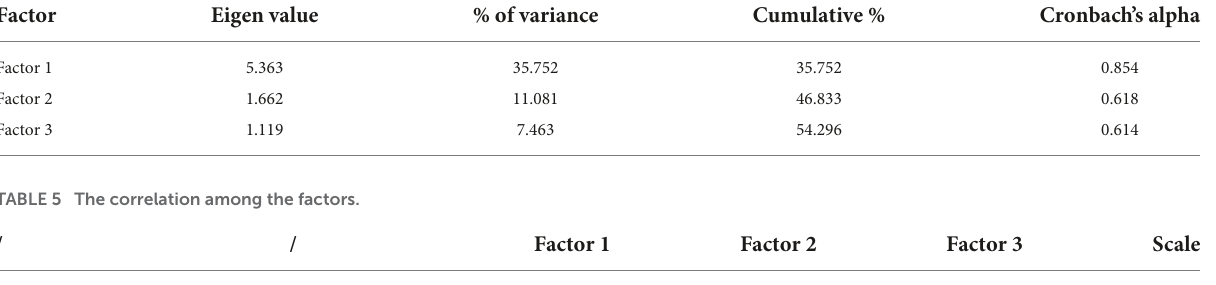
TABLE 4 Extraction sums of squared loadings.